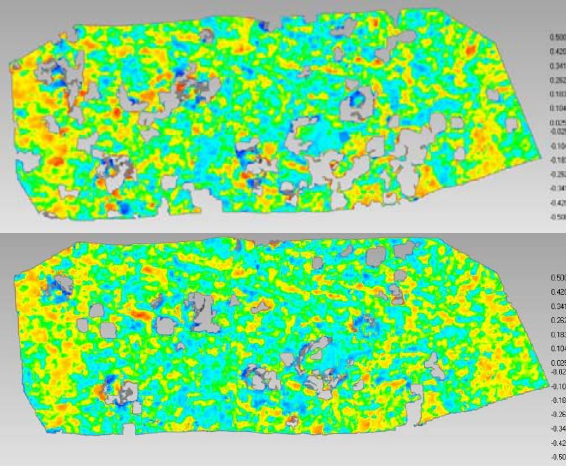
Figure 10. Colour coded error map of the Anorthosite sample DTM for 10° (top) and 50° (bottom) illumination angle The presence of spot reflections on the Anorthosite surface (from the glue used to attach the pins and from tiny crystals) produces saturated pixels converted in holes in the DTMs. Furthermore the shadows created by the surface roughness (the surface curvature is higher with respect to the Concrete as shown in the Figure 11 c) might check the number of good matches.